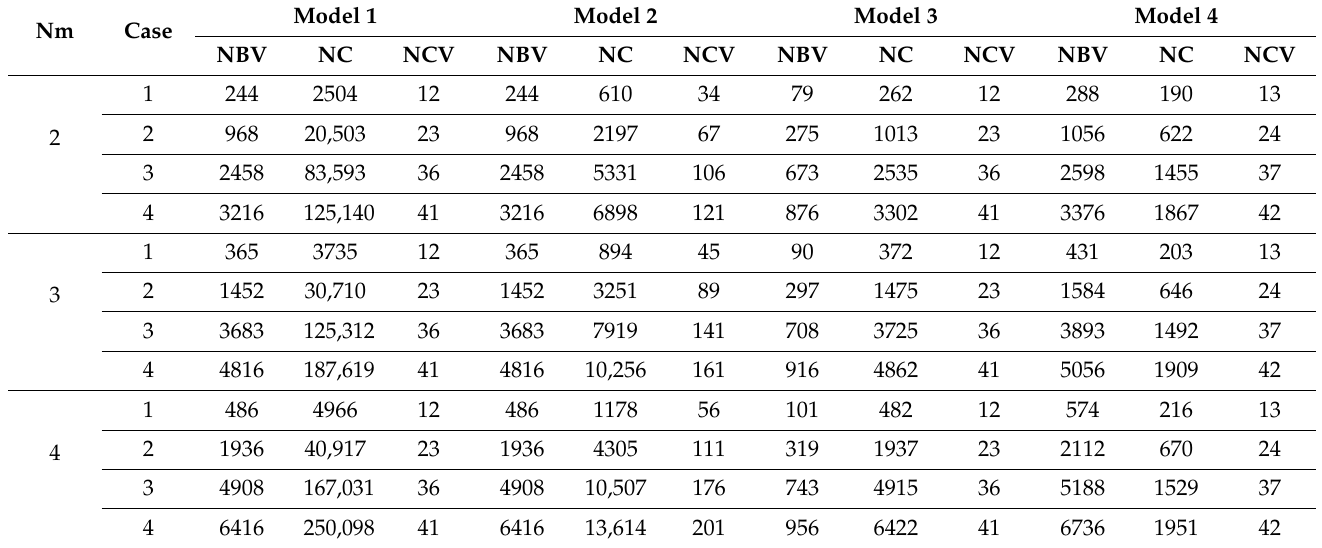
Table 2. Comparison of size